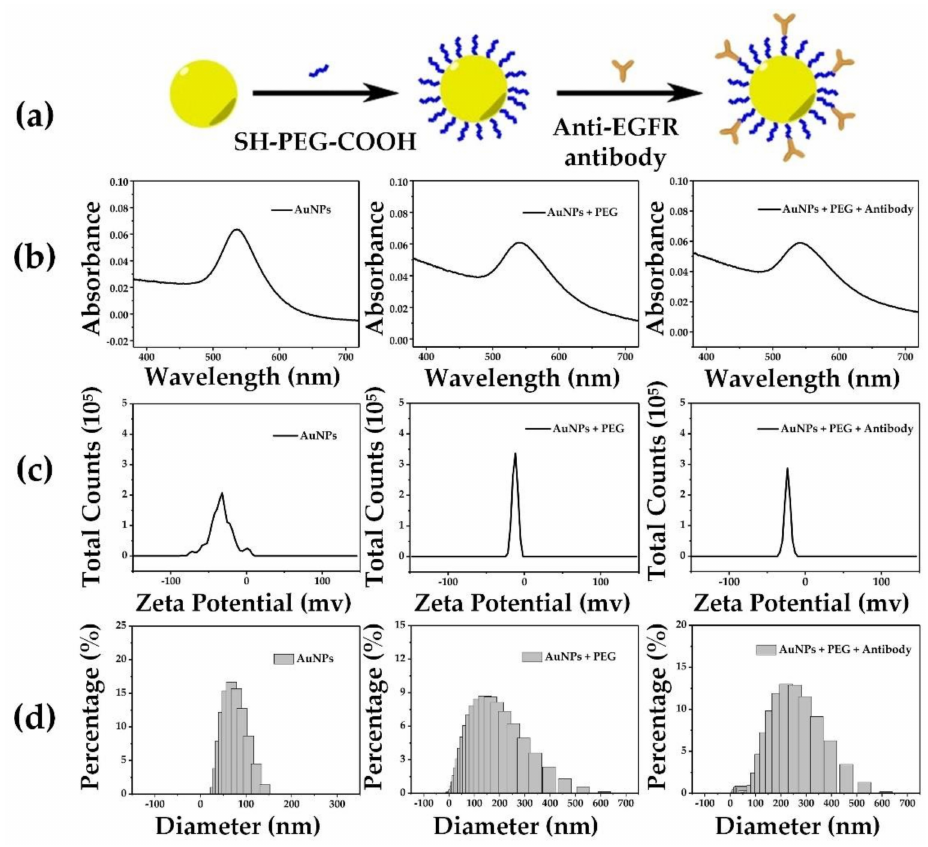
Figure 2. Design and characterization of EGFR antibody-modified AuNPs. Left panel: the AuNPs; middle panel: the AuNPs@PEG complex; right panel: the AuNPs@PEG@antibody complex. ( a ) A schematic presentation of AuNPs’ bioconjugation; ( b ) the UV–VIS spectra of naked AuNPs,